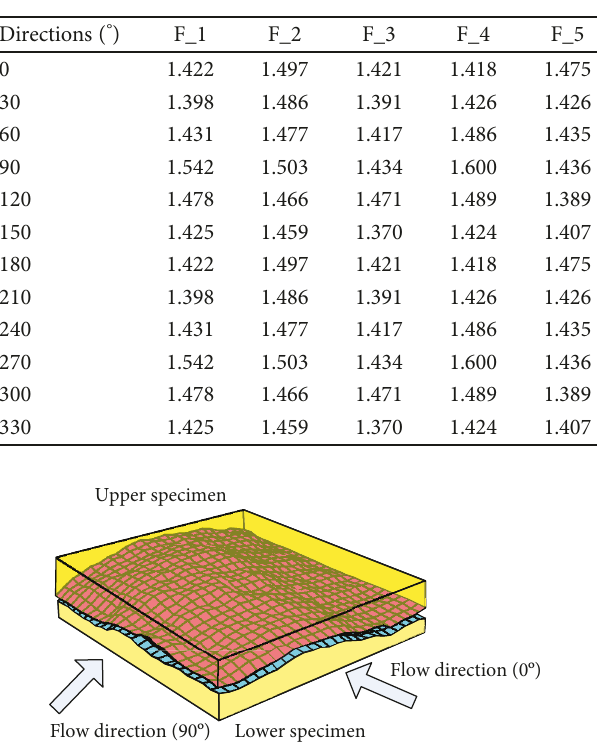
Table 2: The fractal dimensions at di ff erent directions.